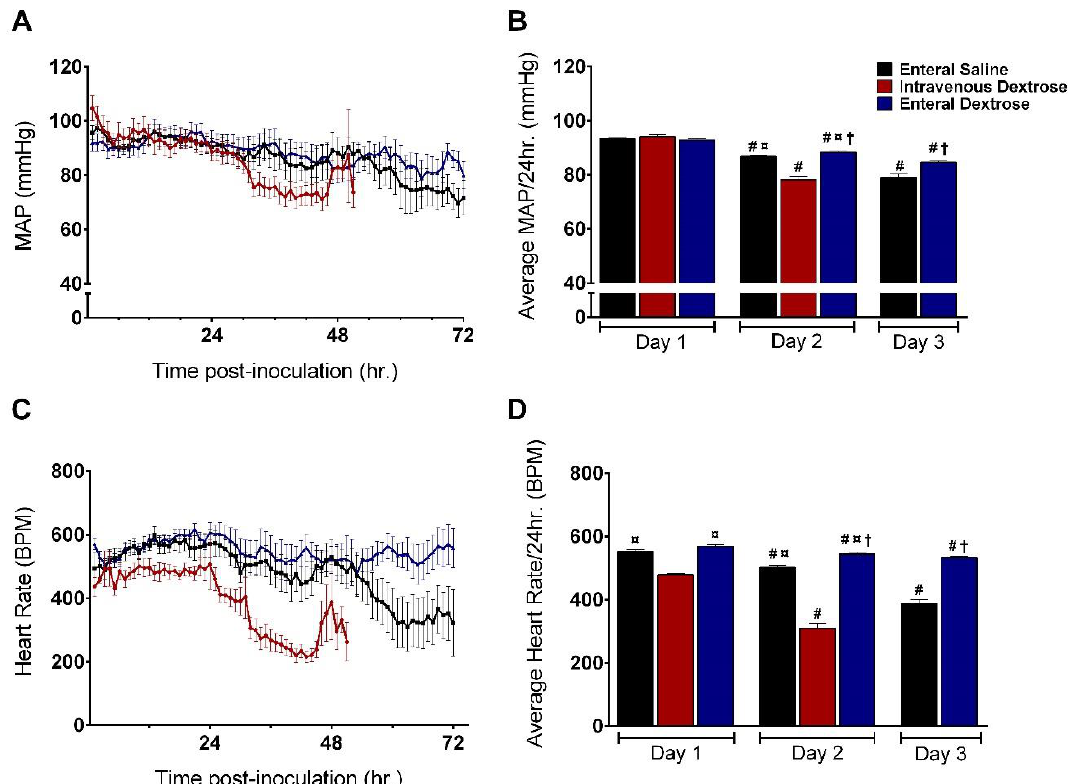
Figure 3. Hemodynamic effects of exogenous dextrose in Klebsiella pneumoniae (KP) infection. ( A ) Average mean arterial pressure (MAP) by hour following exposure to KP. Values represent data for surviving mice; mice are censored at the time of death or at the time that MAP fell below the specified threshold (60 mmHg) for one hour. ( B ) Average daily MAP by infusion group. # = p < 0.05 compared to average MAP on prior day within same group; (cid:3) = p < 0.05 compared to IV dextrose on same day; † = p < 0.05 compared to enteral saline group on same day. (C) Average heart rate (HR) by hour following KP exposure. (D) Average daily HR by infusion group. # = p < 0.05 compared to average MAP on prior day within same group; (cid:3) = p < 0.05 compared to IV dextrose on same day; † = p < 0.05 compared to enteral saline group on same day. Abbreviations: BPM: beats per